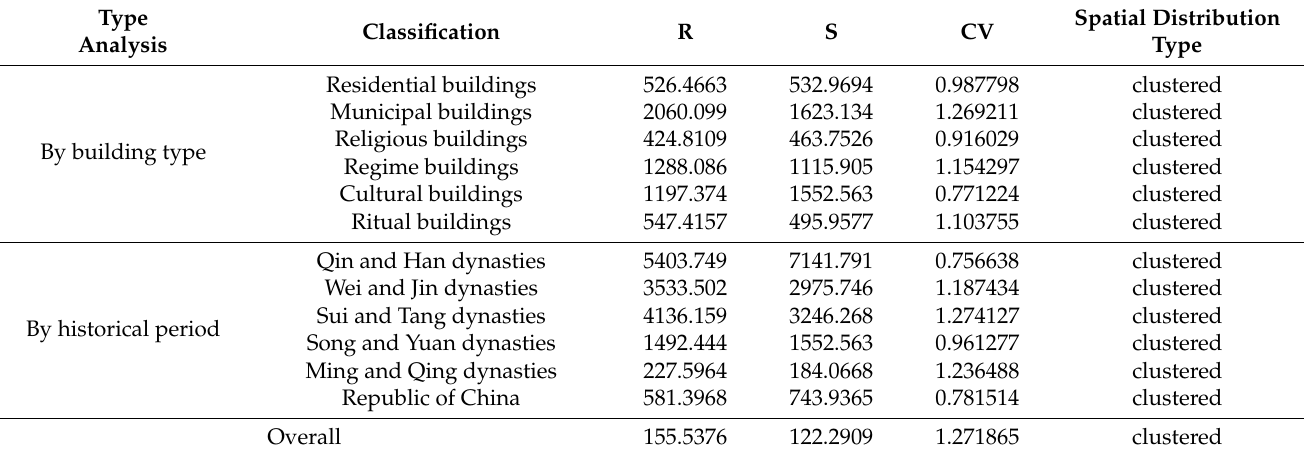
Table 2. The Voronoi diagram calculations for the distribution of historical buildings in the Songshan region.